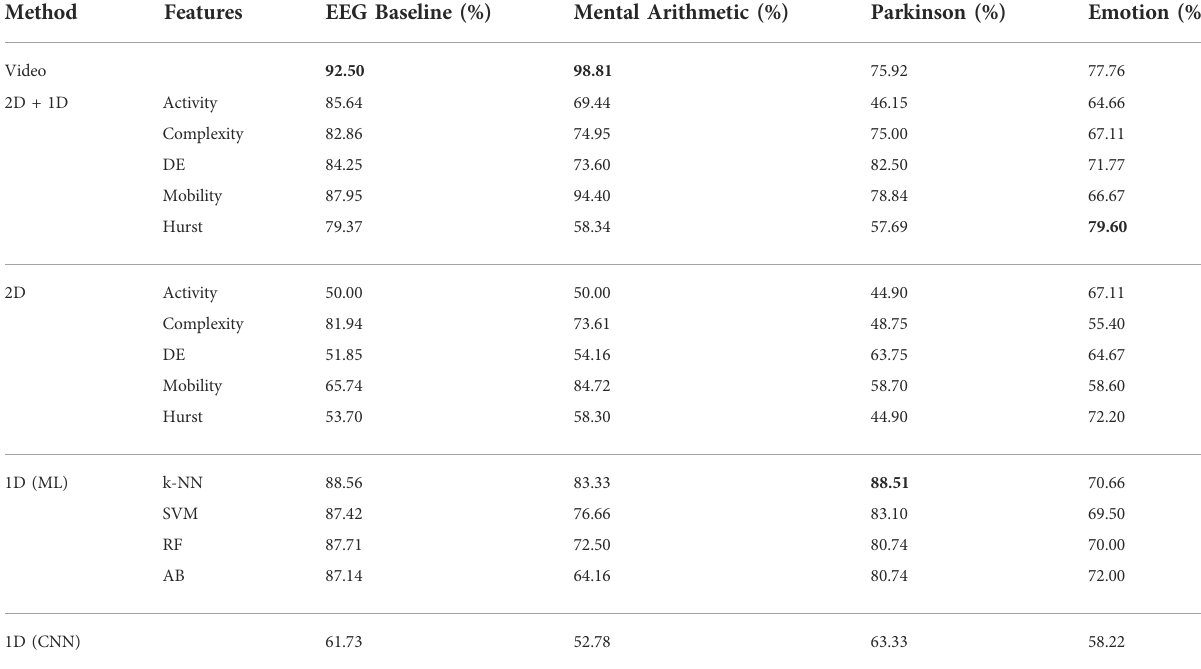
TABLE 3 Mean accuracies obtained using the proposed methodologies on the mentioned datasets.